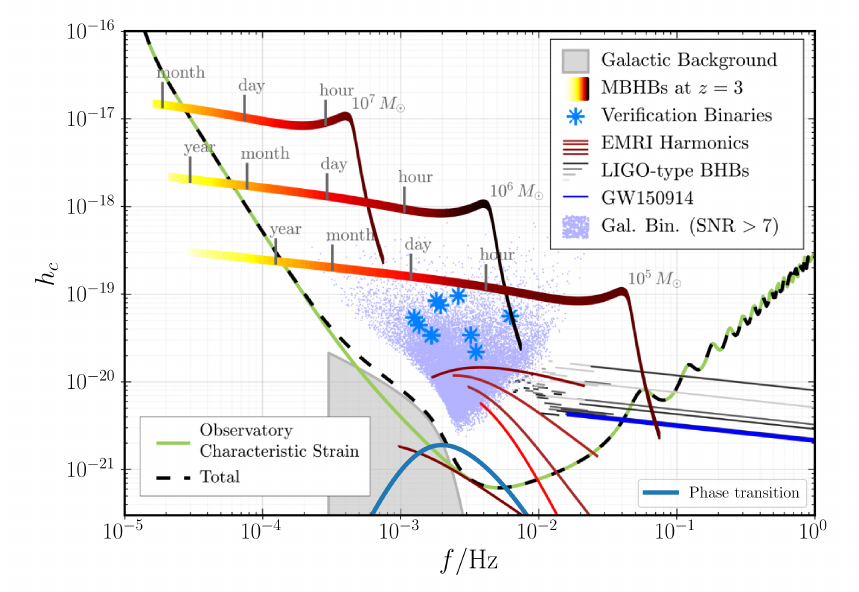
Figure 19: The expected sensitivity of LISA and possible astrophysical sources of gravitational waves. The phase transition signal, indicated by the blue line, is pre- dicted for a transition with nucleation temperature T α = 0.3, transition rate to Hubble rate ratio β/ H Background figure taken from [ 9 ]